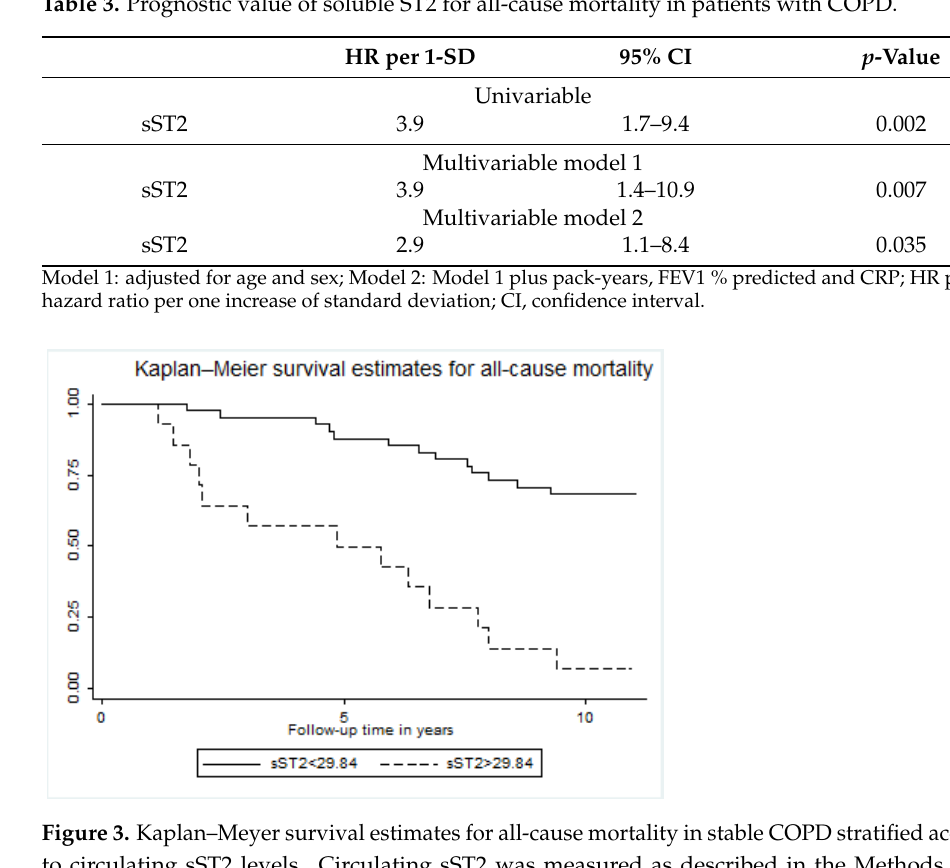
Table 3. Prognostic value of soluble ST2 for all-cause mortality in patients with COPD.